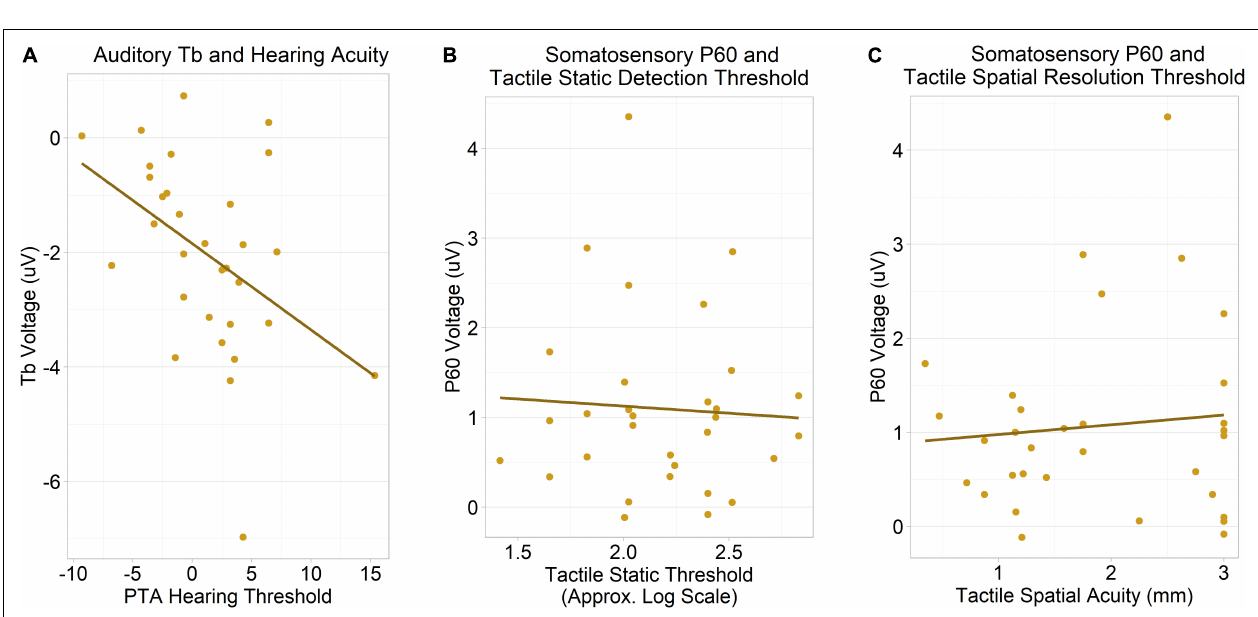
FIGURE 5 | Tactile thresholds in each group. (A) Thresholds for detection of static (non-vibrating) tactile stimuli, specifically Von Frey hairs, using an approximate/theoretical log scale of forces provided by the manufacturer (Stoelting Co, 2001). (B) Thresholds for recognition of the orientations of tactile gratings of different widths (in mm).